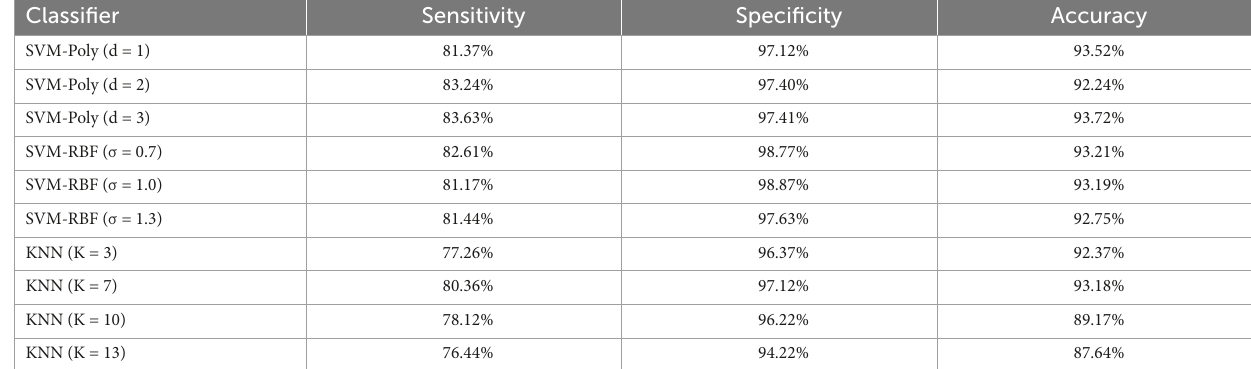
TABLE 3 Performance of the KNN and SVM classifiers with different parameters using the combined feature vector.